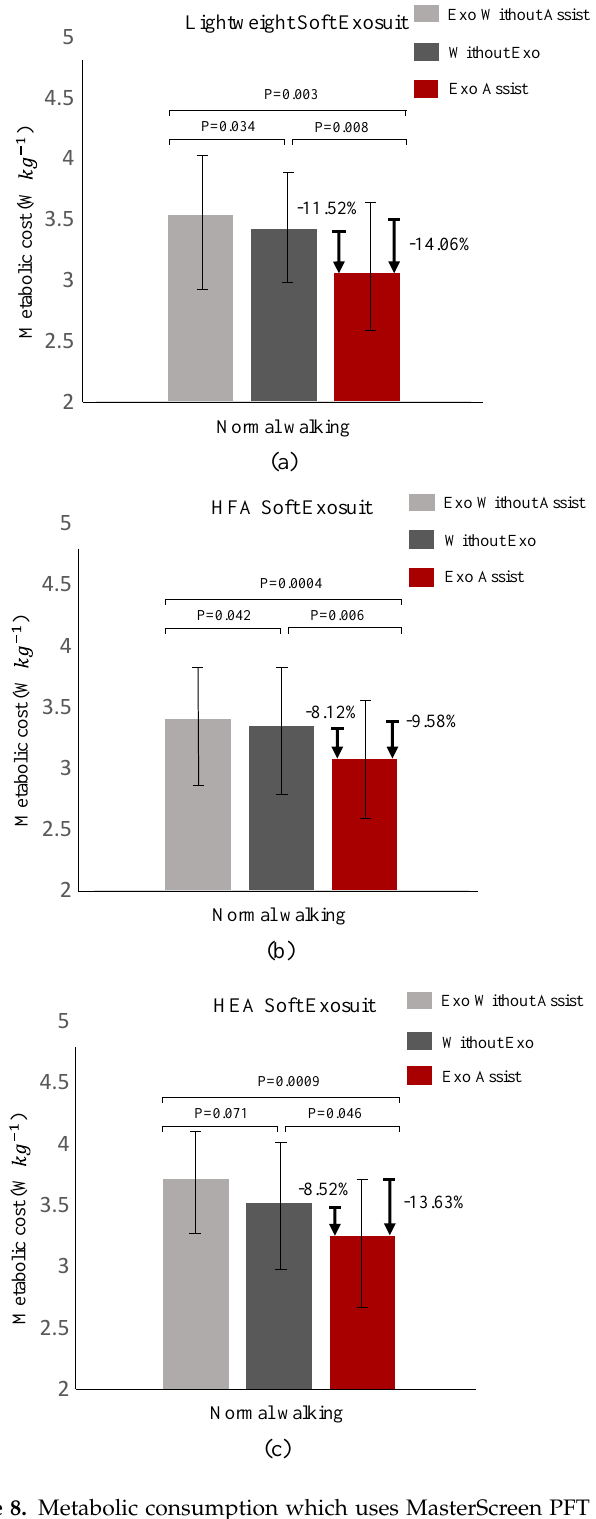
Figure 8. Metabolic consumption which uses MasterScreen PFT System to obtain. ( a ) Using the lightweight soft exosuit to do metabolic consumption experiments through wearing the exosuit without power, without using the exosuit and wearing the exosuit with power respectively. ( b ) Similar to ( a ), using the HFA soft exosuit to do metabolic consumption experiments. ( c ) Similar to ( a ), using the HEA soft exosuit to do metabolic consumption